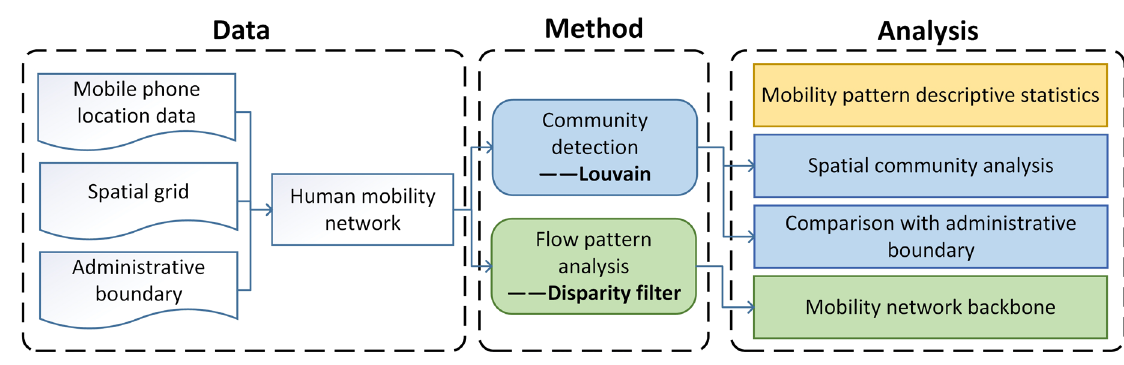
Figure 2 . The research